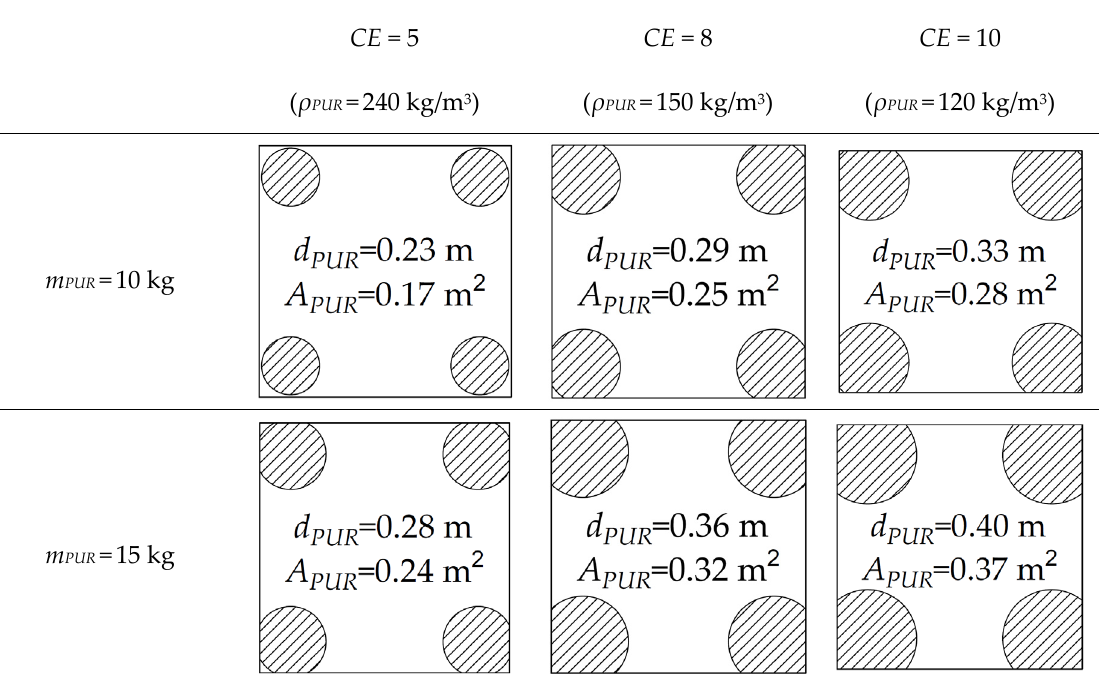
10 of 22 Table 2. Density, ρ , elastic properties (shear and bulk moduli, G ref and B ref ) at a reference confining pressure (80 kPa) and friction angle, φ ’ , for the PDMY material.